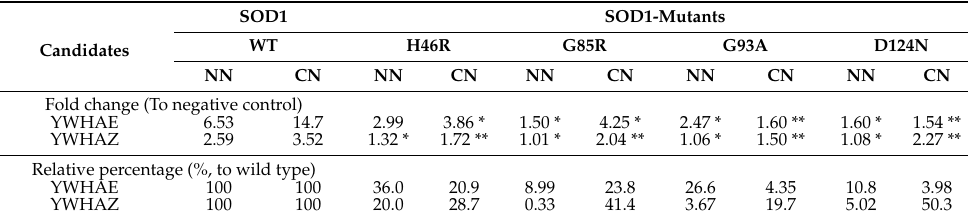
Table 1. Impacts of SOD1 mutants on its interactions with YWHAE and